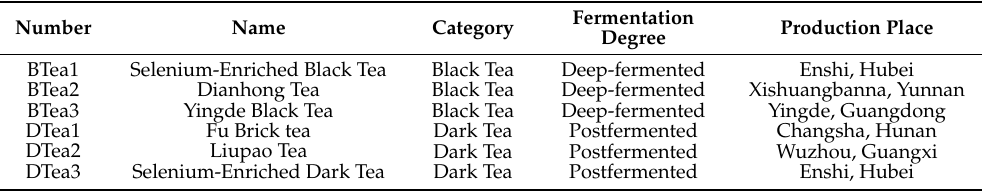
Table 1. The detailed information of three black teas and three dark